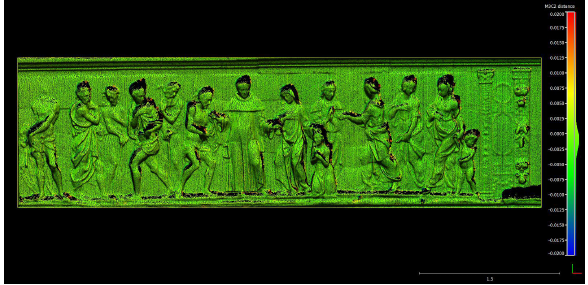
Figure 7. Comparison (based on signed distances) between scan models obtained with the C10 and 5010C